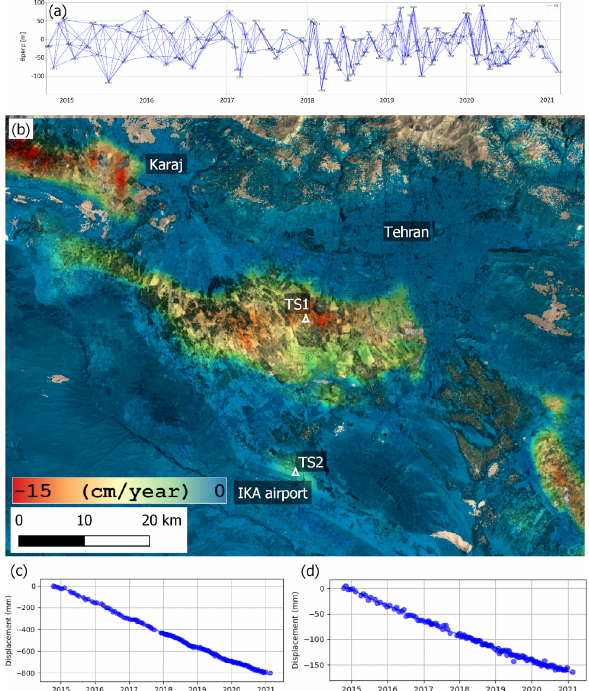
Figure 4. InSAR time series analysis of LiCSAR products in Tehran between 2014 and 2021. (a) network of interferograms. (b) linear rate of displacement in satellite LOS direction. (c) and (d) time series of displacement at sample points indicated by TS1 and TS2 in (b). The average rate of displacement indicates several subsidence areas near Tehran with a peak exceeding 15 cm/year. (c) and (d) show two examples of deformation time series at locations indicated by TS1 and TS2. TS1 is located in the main subsidence bowl to the southwest of Tehran. TS2 is located near Tehran’s international airport. Background imagery for (b) Google Earth Image Landsat/Copernicus, Map data